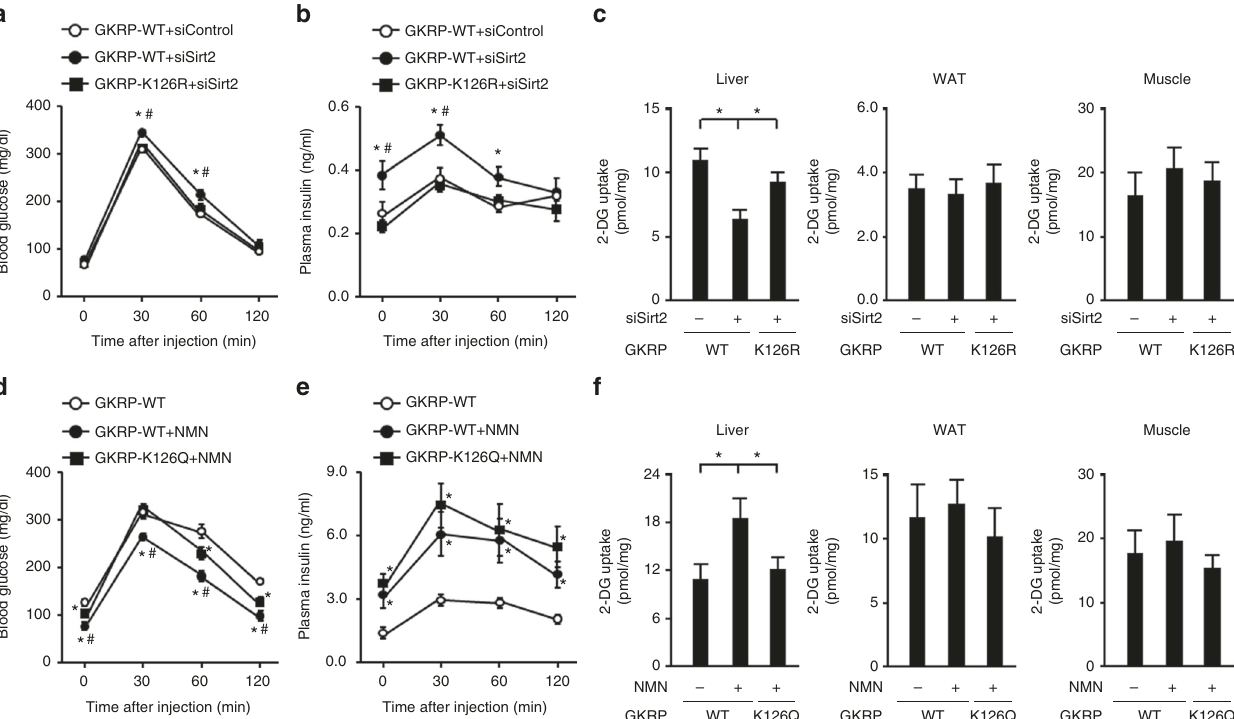
Fig. 6 Deacetylation of K126 on GKRP plays an essential role in NAD+ /Sirt2-dependent hepatic glucose uptake. a – c Effect of adenovirus-mediated hepatic overexpression of GKRP-K126R or GKRP-wild-type (GKRP-WT) in hepatic Sirt2 knockdown mice on the levels of blood glucose ( n = 5) ( a ), plasma insulin ( n = 5) ( b ), and 2-deoxyglucose (2-DG) uptake in the liver, WAT, and skeletal muscle ( n = 4) ( c ) after glucose administration (2 g/kg). d – f Effect of adenovirus-mediated hepatic overexpression of GKRP-K126Q or GKRP-WT in high-fat diet (HFD)-fed mice administered NMN on the levels of blood glucose ( n = 5) ( d ), plasma insulin ( n = 5) ( e ), and 2-DG uptake in the liver, WAT, and skeletal muscle ( n = 4) ( f ) during glucose administration (1 g/kg). * P < 0.05; one-way ANOVA with the Fisher ’ s PLSD post-hoc test ( c , f ), * P < 0.05, vs. WT in ( a , b , d , e ), # P < 0.05, WT+siSirt2 vs. K126R+siSirt2 ( a , b ) or WT+NMN vs. K126Q+NMN ( d , e ); one-way ANOVA with the Fisher ’ s PLSD post-hoc test. Error bars show human embryonic kidney cells, were obtained from Cell Biolabs (San Diego, CA). HEK 293 cells were cultured in DMEM with 10% FBS and transfected with each plasmid for 24 h using FuGENE 6 transfection reagent (Promega, Madison, WI). HEK 293 cells were stimulated with NAM (20 μ M ), Ex-527 (10 μ M ), AGK2 (10 μ M ), and TSA (1 μ M ) for 6h. The cell lines were regularly tested for mycoplasma contamination. Biochemical analysis . NAD+ and 2-DG levels in primary hepatocytes and tissue samples were measured using a NAD/NADH quanti fi cation kit (BioVision, Mountain View, CA) and a 2-DG Uptake Measurement Kit (Cosmo Bio, Tokyo, Japan), respectively. Animals . All animal experiments were approved by the Animal Ethics Committee of Kanazawa University and were performed according to the Animal Ethics Committee ’ s guidelines for the care and use of laboratory animals at Kanazawa University. Eight-week-old male C57BL/6J and db/db mice were obtained from Japan SLC (Shizuoka, Japan) and maintained in a temperature-controlled envir- onment with a 12-h light/dark cycle with free access to food and water. An HFD (61% of energy from fat) (D12492; Research Diet, New Brunswick, NJ) was fed to 8-week-old mice for 12 weeks. In NMN experiments, mice were intraperitoneally injected with NMN (500 mg/kg body weight) 6 h before each analysis. Liver- speci fi c knockdown mice were generated by siRNA as described previously 27 . For the in vivo 2-DG uptake assay, except in hyperinsulinemic-hyperglycemic clamp experiments, 2-DG (200 μ mol/kg) was injected into the tail vein 10 min after glucose administration (2 g/kg body weight for fasted lean mice; 1g/kg body weight for fasted HFD mice). Liver, epididymal WAT, and soleus muscle samples were collected 10 min after 2-DG injection. For in vivo immunoprecipitation and immunoblot analysis of the GK − GKRP binding assay, livers were obtained from mice 30min after glucose administration (4g/kg) after 16-h fasting. Cages of mice were allocated to experimental groups by random draw. The investigator was not blinded to the group allocation. Glucose tolerance testing . For intraperitoneal glucose tolerance tests, mice were intraperitoneally administered 1g/kg body weight glucose for HFD-fed mice and 2 g/kg body weight glucose for NC-fed mice, with or without continuous intravenous administration of somatostatin (3 μ g/kg/min) (Sigma) through a jugular catheter